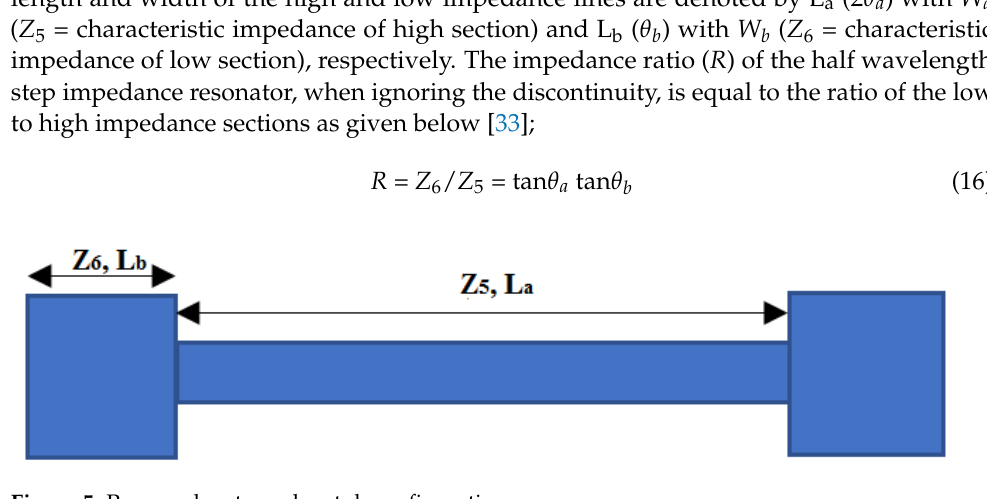
Figure 6. Schematic diagram of the dual-notched UWB BPF. Table 1. Proposed filter dimensions in mm. L